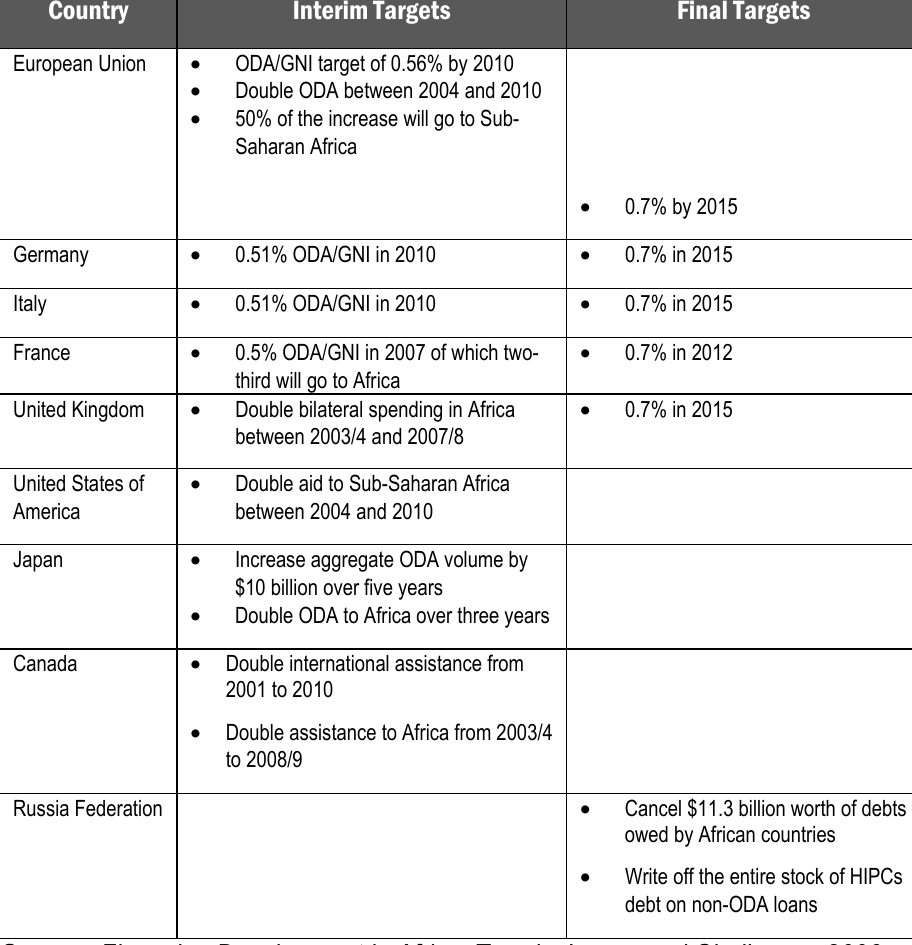
Country Interim Targets Final